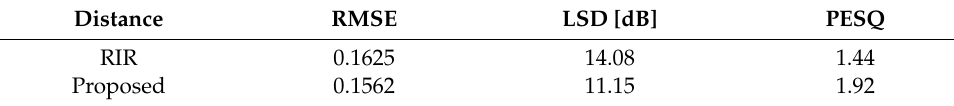
Figure 7. Spectrogram examples of ( a ) the recorded signal, ( b ) the signal artificially generated by RIR, and ( c ) the signal generated by the proposed method. Table 1. LSD and RMSE between recorded and generated